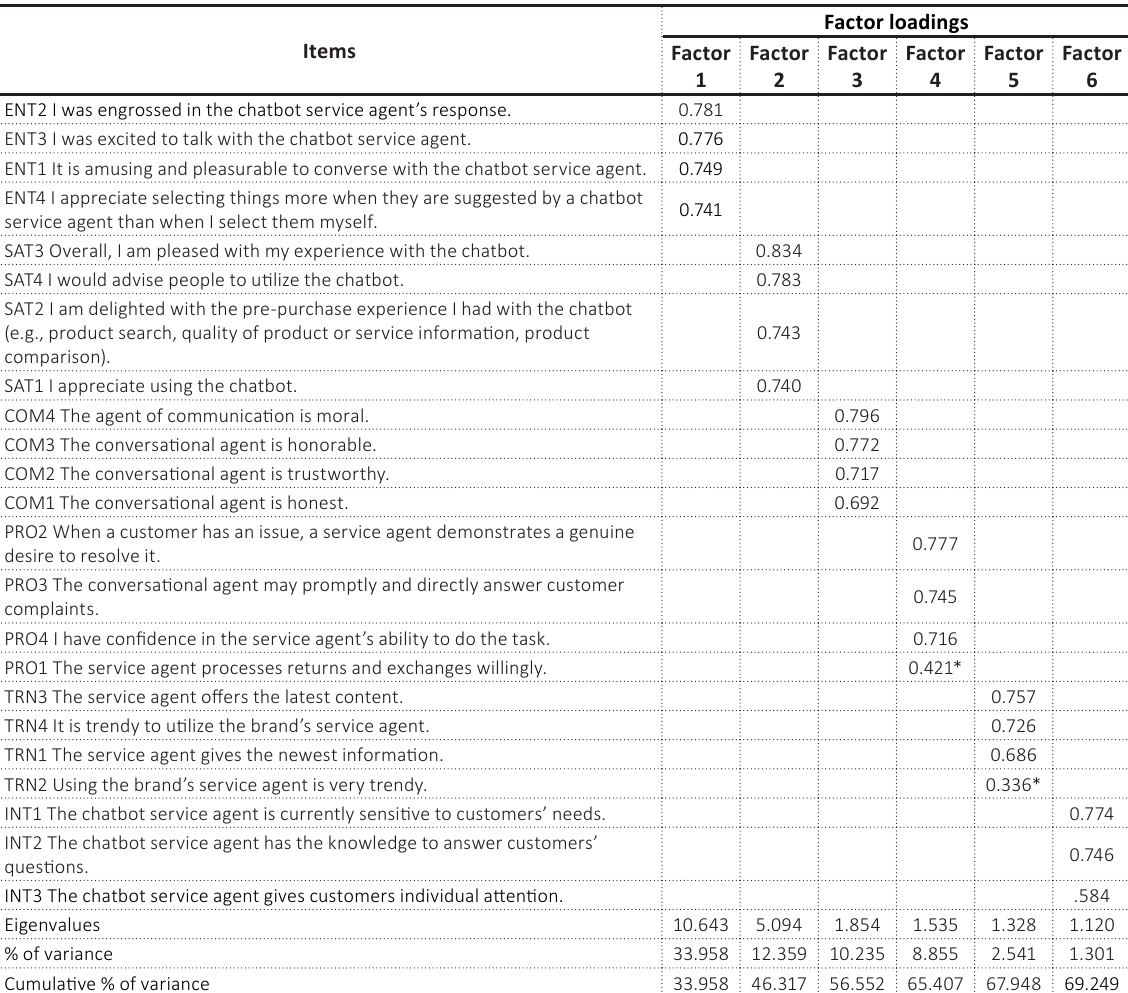
Table A1. Factor analysis